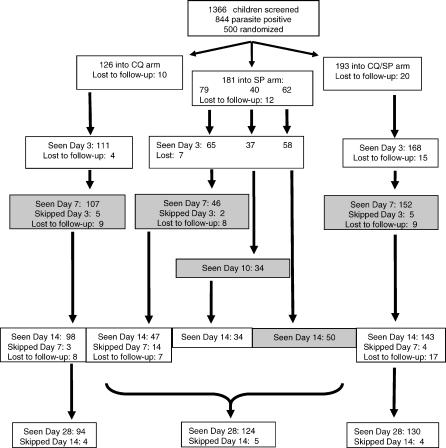
CONSORT FlowchartA total of 1,366 children was screened, and 500 were randomised. Children randomised to receive SP on Thursday or Friday (N = 79), were scheduled for standard follow-up and thus fulfilled the criteria for efficacy evaluation. Follow-up data are shown for these 79, but not for the other SP-treated children. Shaded boxes represent gametocyte screening days [18].